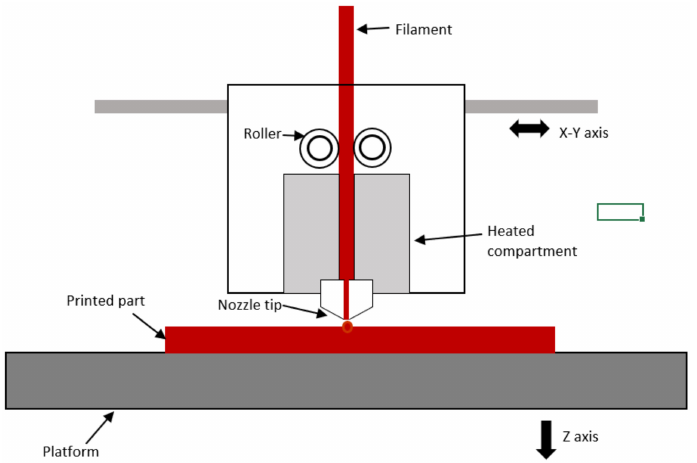
Figure 2. Schematic of